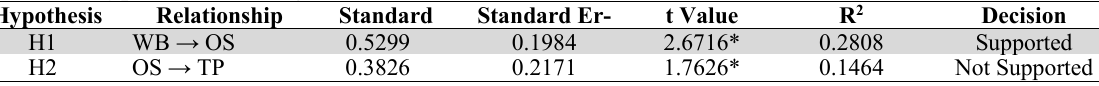
Results of Hypothesis Testing